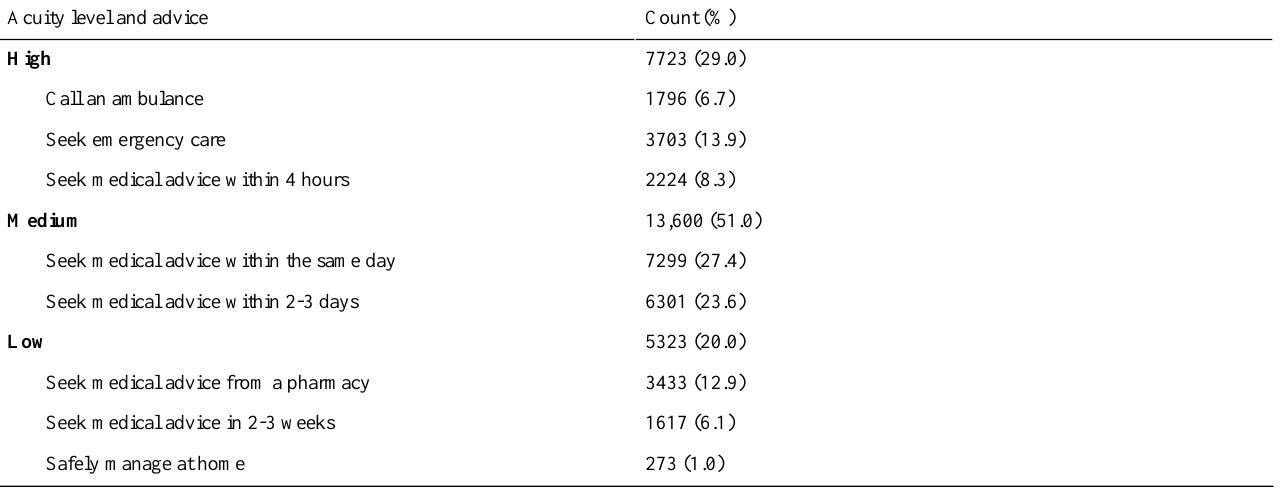
Table 3. Advice and triage acuity levels of the assessments provided by the symptom checker (N=26,646).